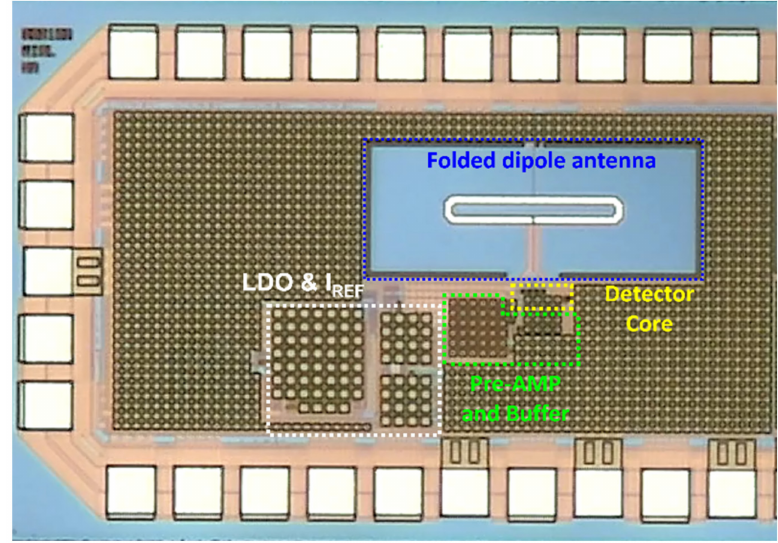
Figure 7. Die photograph of the proposed detector IC implemented using the TSMC 0.25- µ m mixed- signal CMOS process comprising a 200-GHz folded dipole antenna, the proposed detector core, a pre-amplifier, and a voltage buffer.